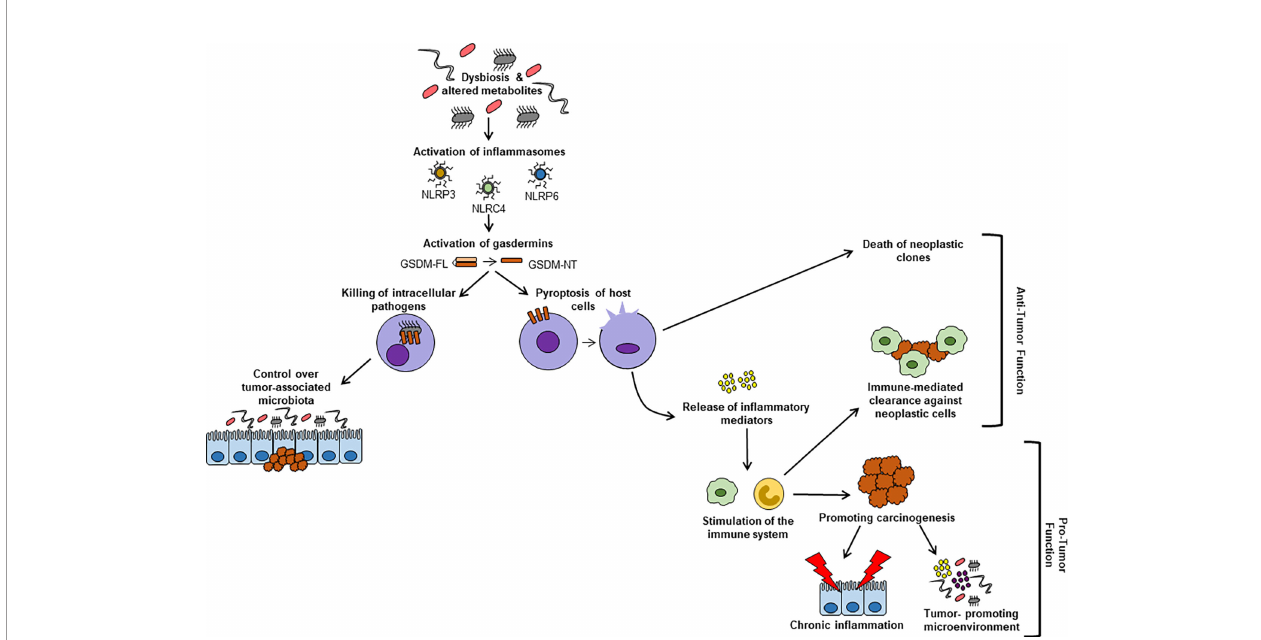
FIGURE 2 | Microbiome-dependent activation of GSDMs and their contribution to CRC pathogenesis. Microbiome-derived stimuli can promote proteolytic cleavage of GSDMs into their active N-terminal domains, which assemble into pores within cell membranes and facilitate the release of in fl ammatory mediators, as well as pyroptotic cell death. Pyroptosis of neoplastic cells can reduce tumor burden. In fl ammatory mediators released via pore-forming GSDMs can stimulate immune cells. This activation can result in either increased clearance of neoplastic cells or in establishing a tolerogenic, tumor-promoting microenvironment. Furthermore, GSDMB can form pores in bacterial membranes, inducing death of intracellular pathogens. Via this mechanism, GSDMB may also be implicated in controlling a tumor- permissive microbiome. GSDM-FL, gasdermin full-length; GSDM-NT, gasdermin N-terminal domain; NLRC, NLR family CARD domain containing; NLRP, NLR pyrin domain-containing